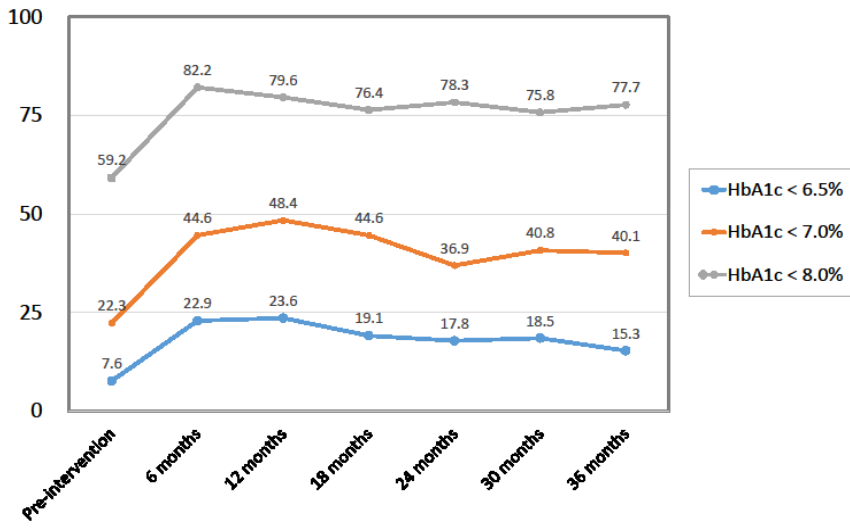
Figure 2. Percentage of patients who reached target HbA1c levels (%).